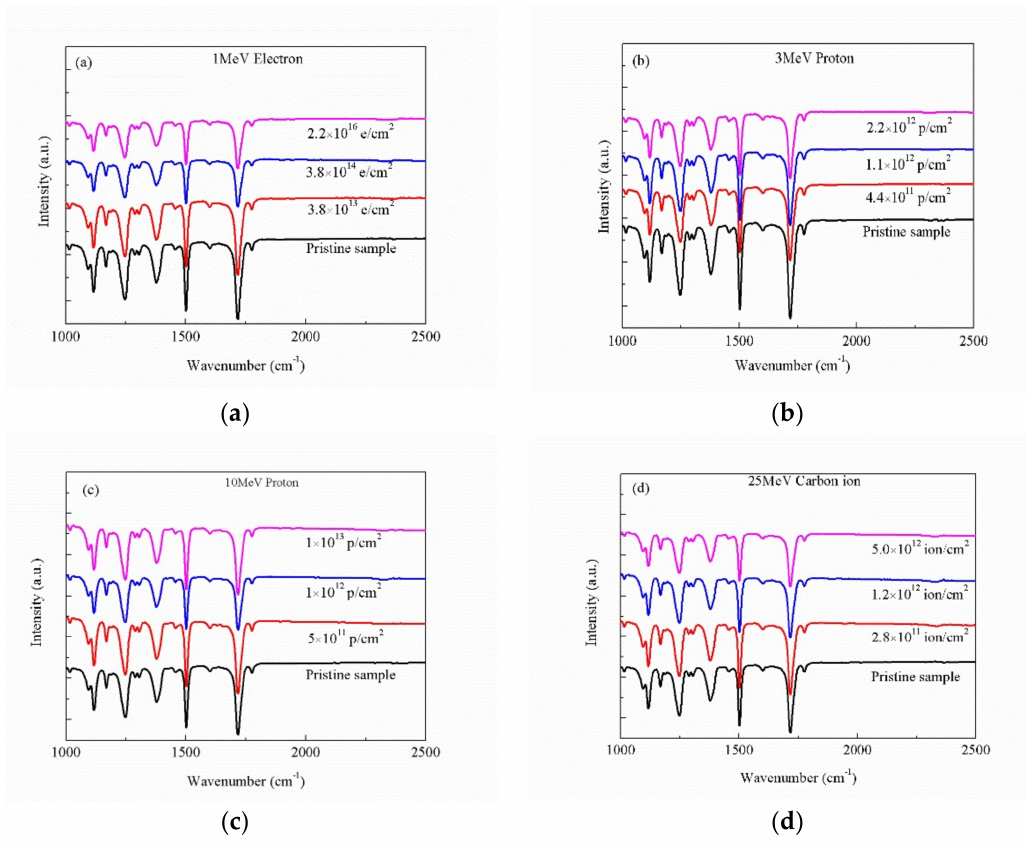
Figure 5. FT-IR curves of pristine and irradiated PI films with di ff erent sources and fluences: ( a ) 1 MeV electron, ( b ) 3 MeV proton, ( c ) 10 MeV proton, and ( d ) 25 MeV carbon